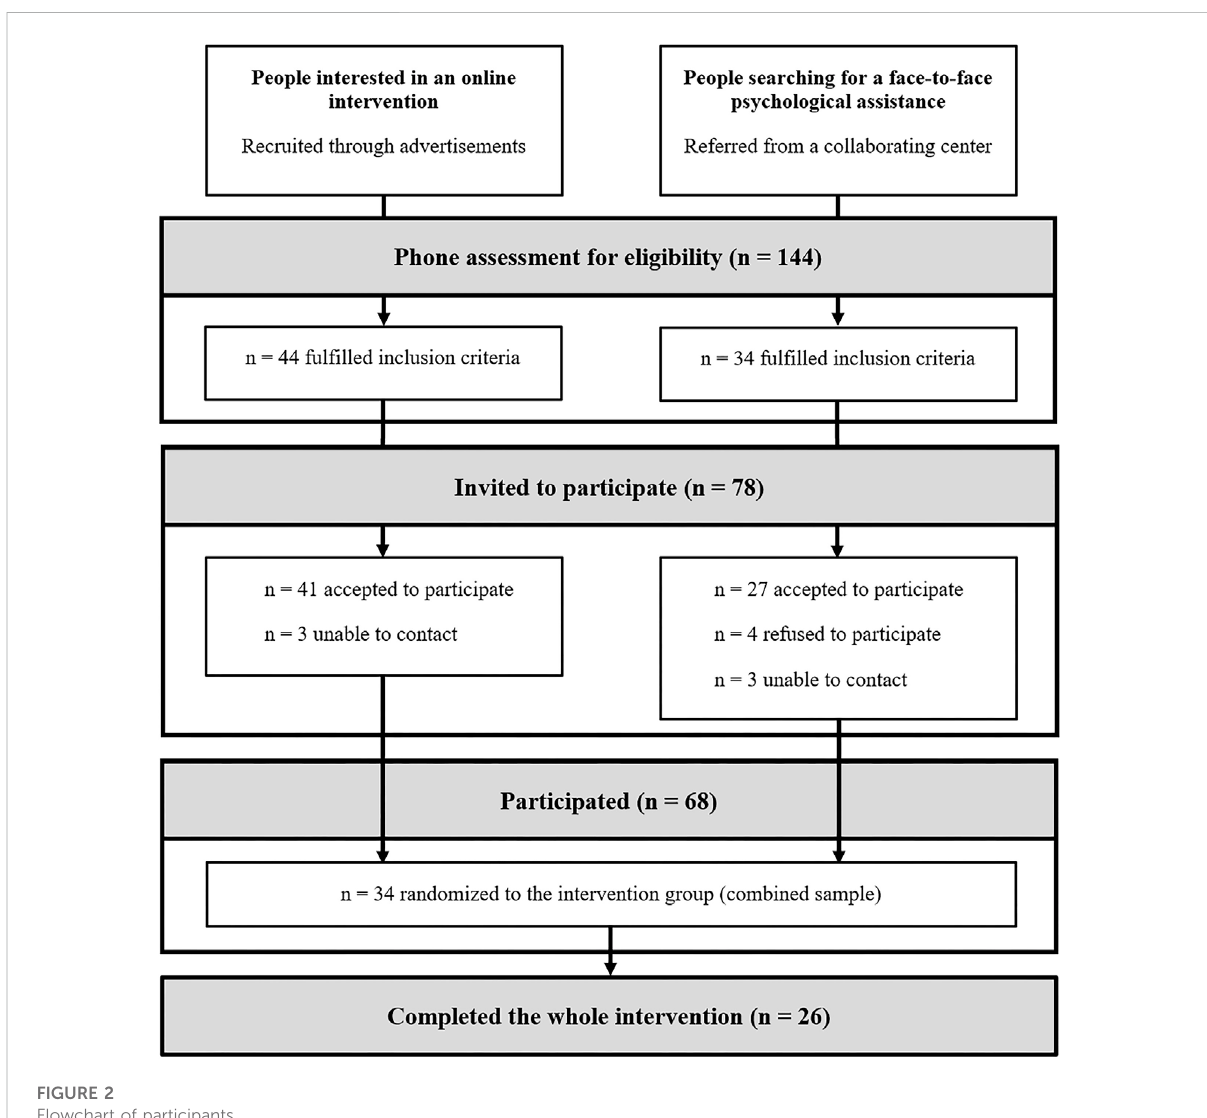
FIGURE 2 Flowchart of